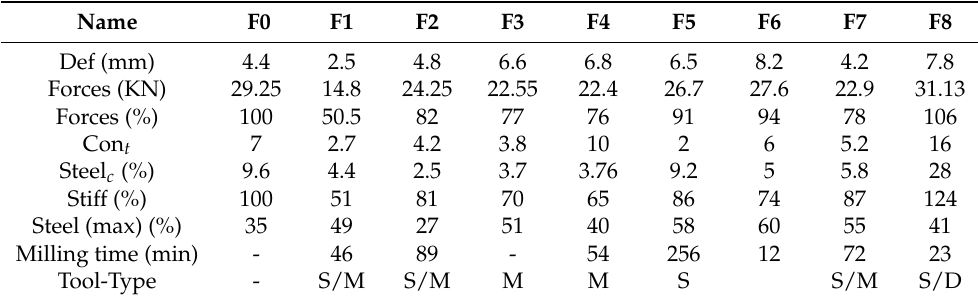
Table 3. Comparing the testing results and the relative manufacturing difficulties of the proposed con-